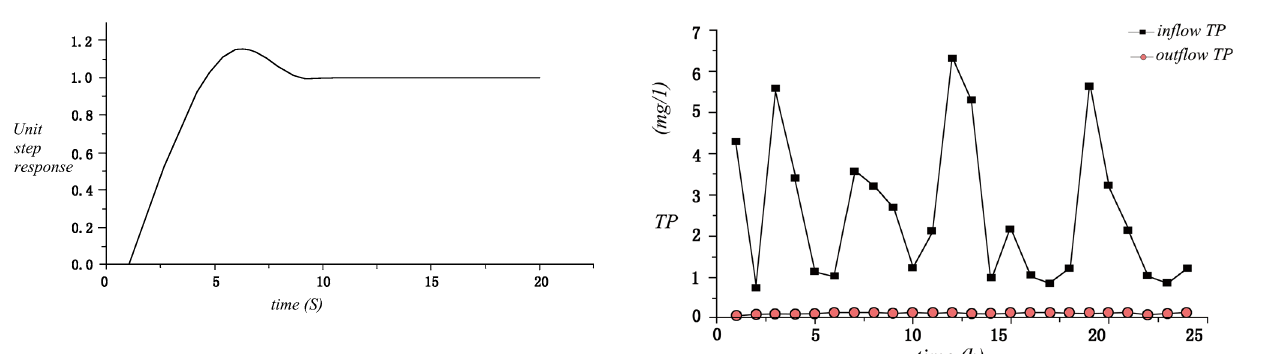
Fig. 8 Fuzzy control model